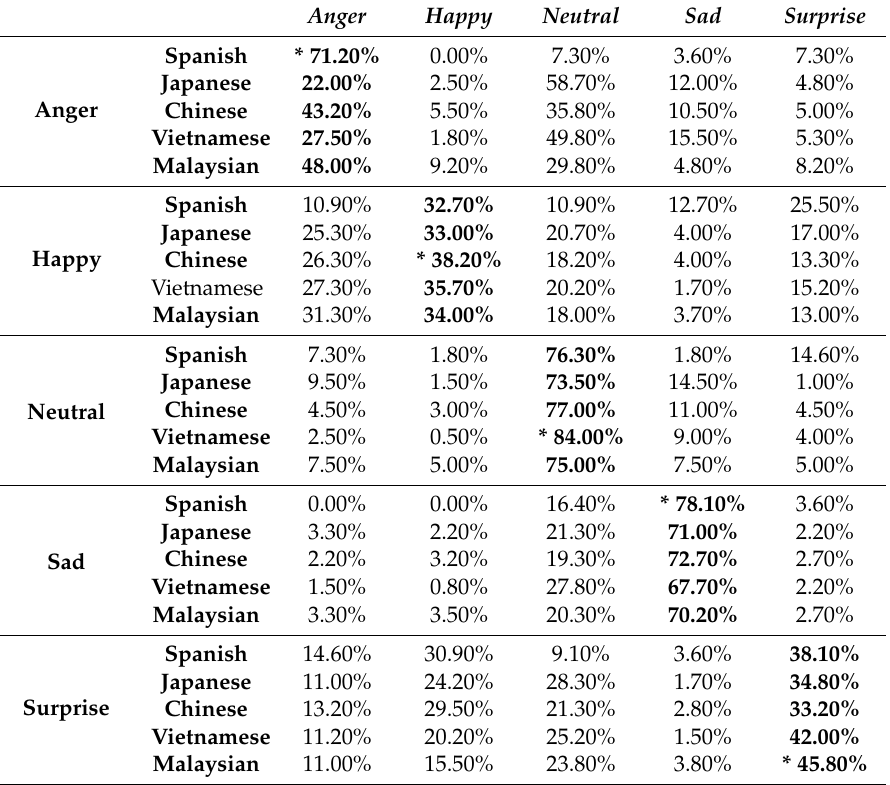
Table 1. Confusion Matrix—Actual Emotion Against Perceived Emotion by Spanish, Japanese, Chinese, Vietnamese and Malaysian Subjects (based on the listening test using the SEV